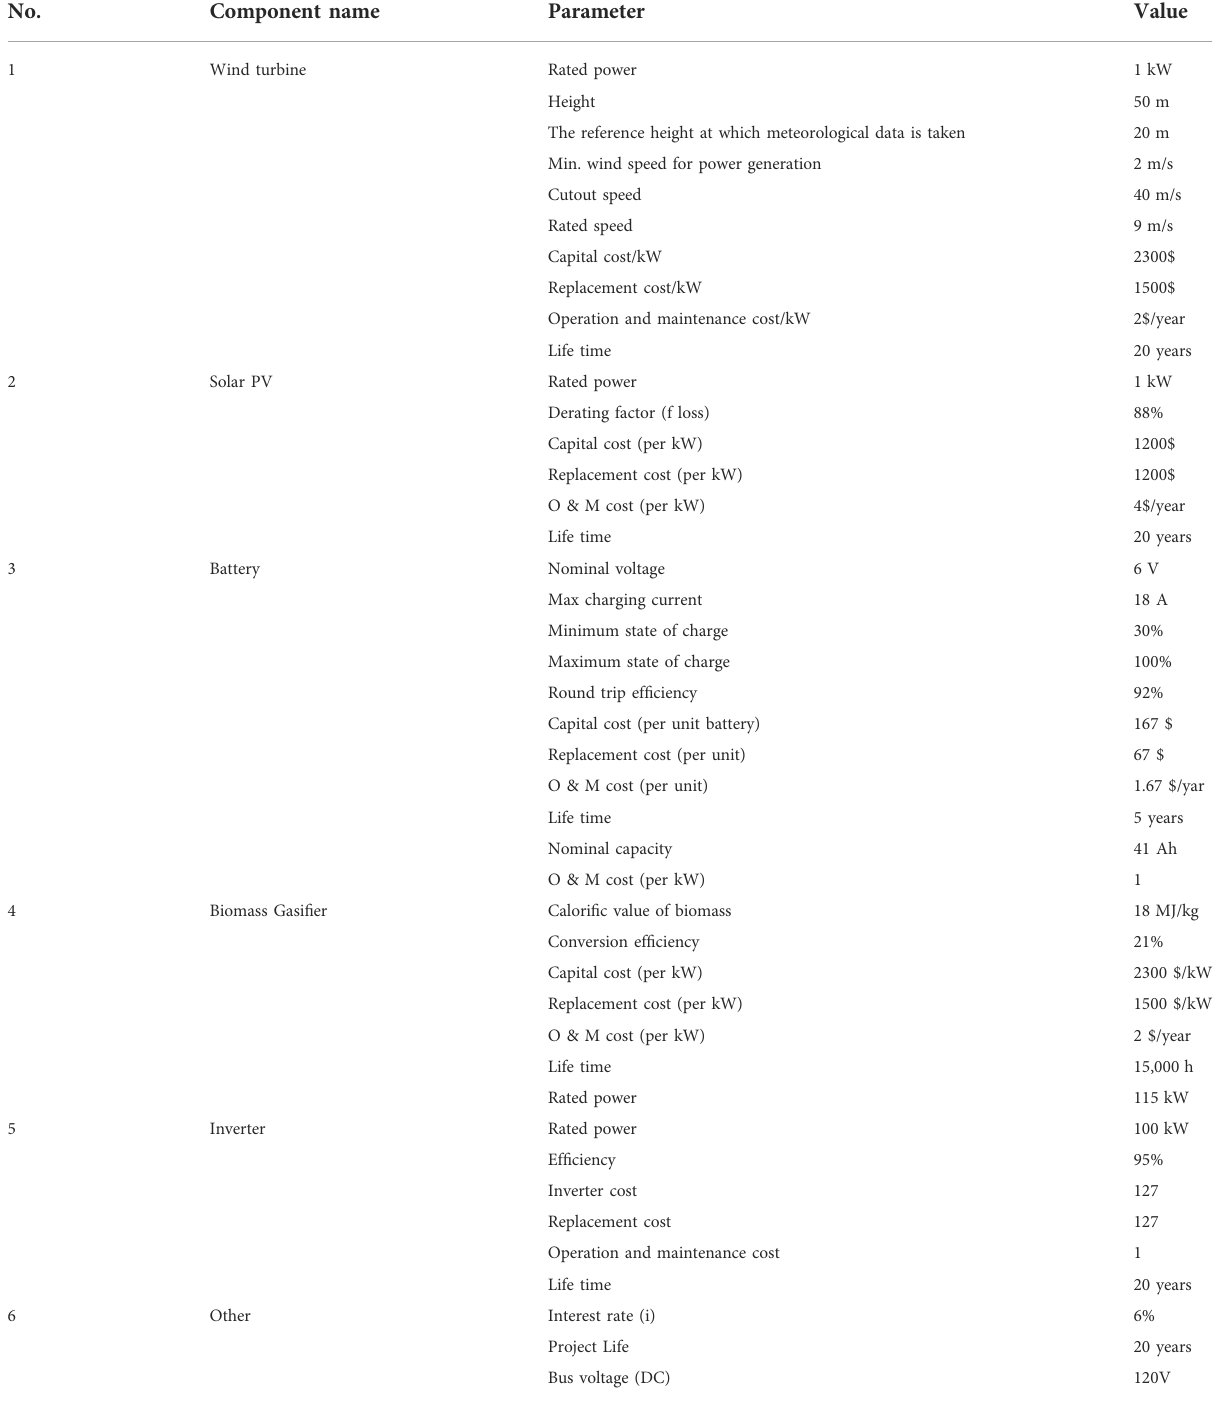
TABLE 1 Technical and economic speci fi cations of the proposed system